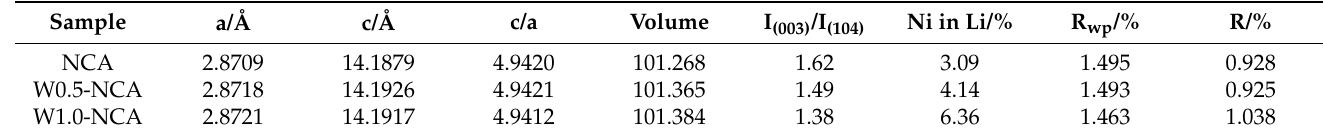
Figure 3. ( a ) XRD patterns of NCA, W0.5-NCA, W1.0-NCA, ( b ) the magnification region of 37.5–66.0°. Table 1. Rietveld refinement of XRD data.